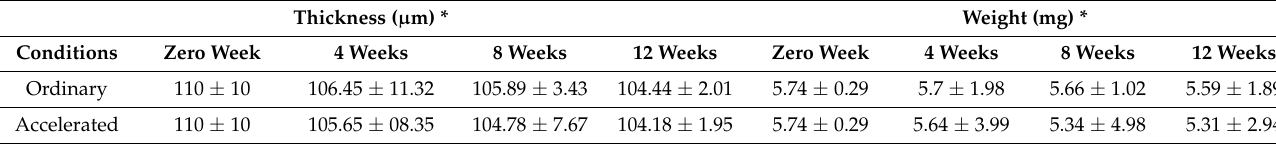
Table 8. Assessment of stability parameters; thickness and weight of tadalafil-loaded oral niosomal film.